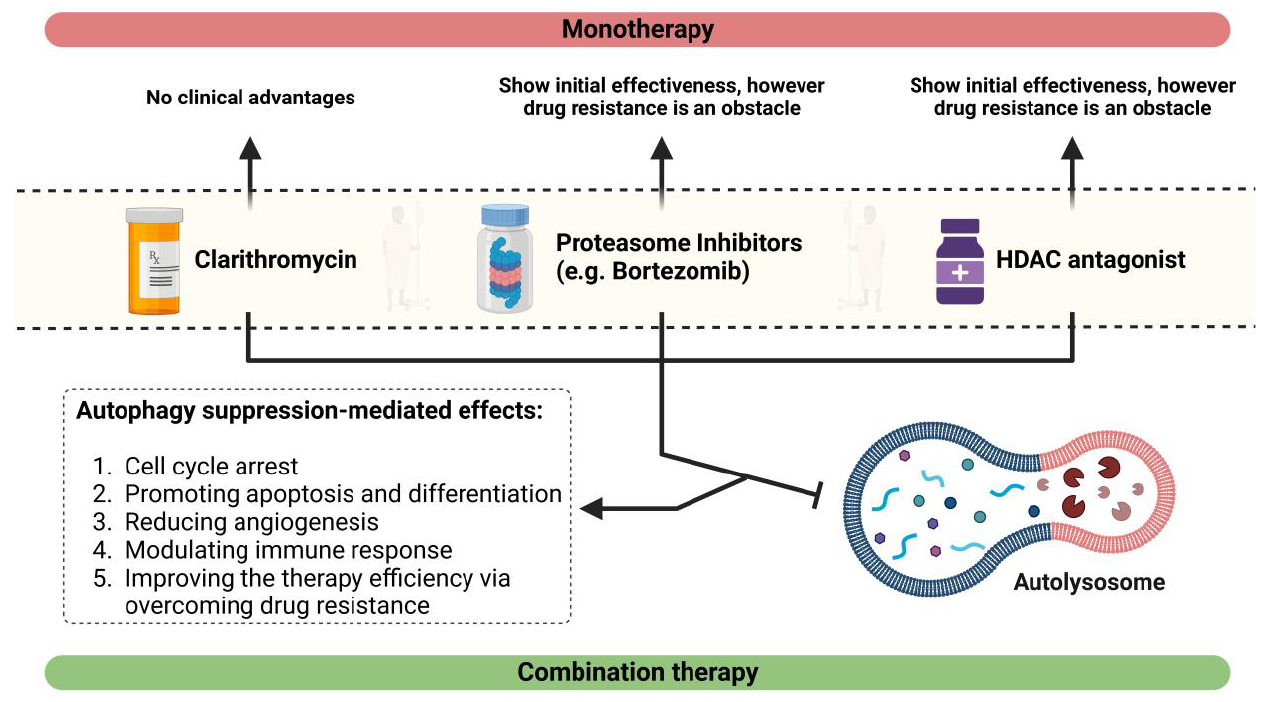
Figure 4. Inhibition of autophagy via combination therapy could improve the treatment efficiency of MM patients. Upon suppression of autophagy, proteasome inhibitors such as bortezomib could induce apoptosis and subsequently rein in cancer development.